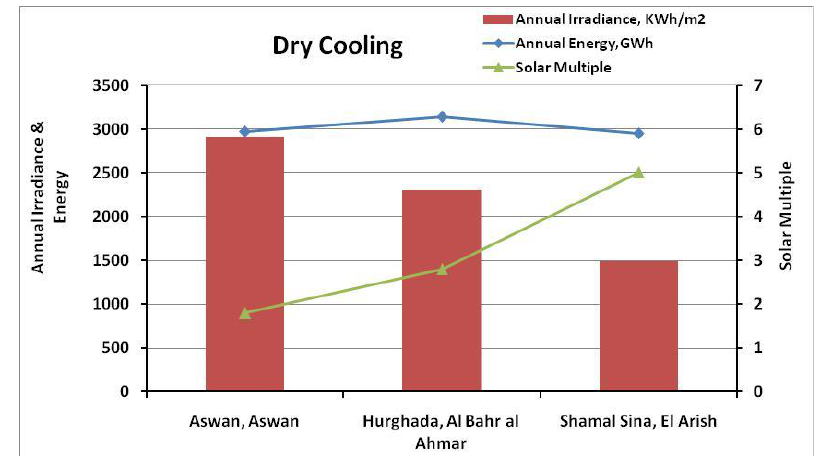
Fig. 5. Annual energy and annual irradiance with SM and locations.